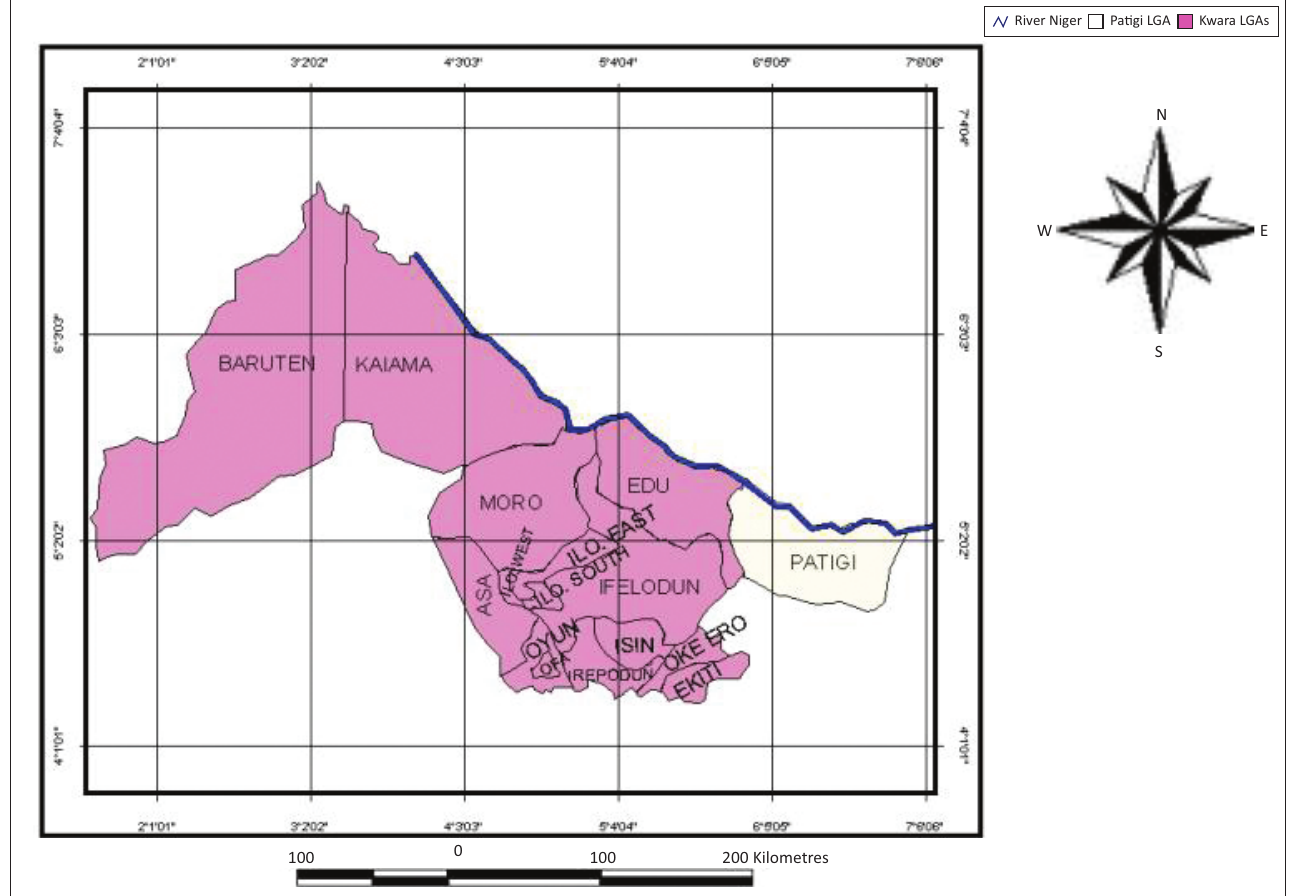
FIGURE 1: Map of Kwara